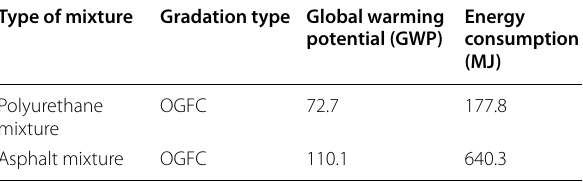
Table 6 The comparison of environmental impact analysis between the polyurethane mixture and asphalt mixture [39]